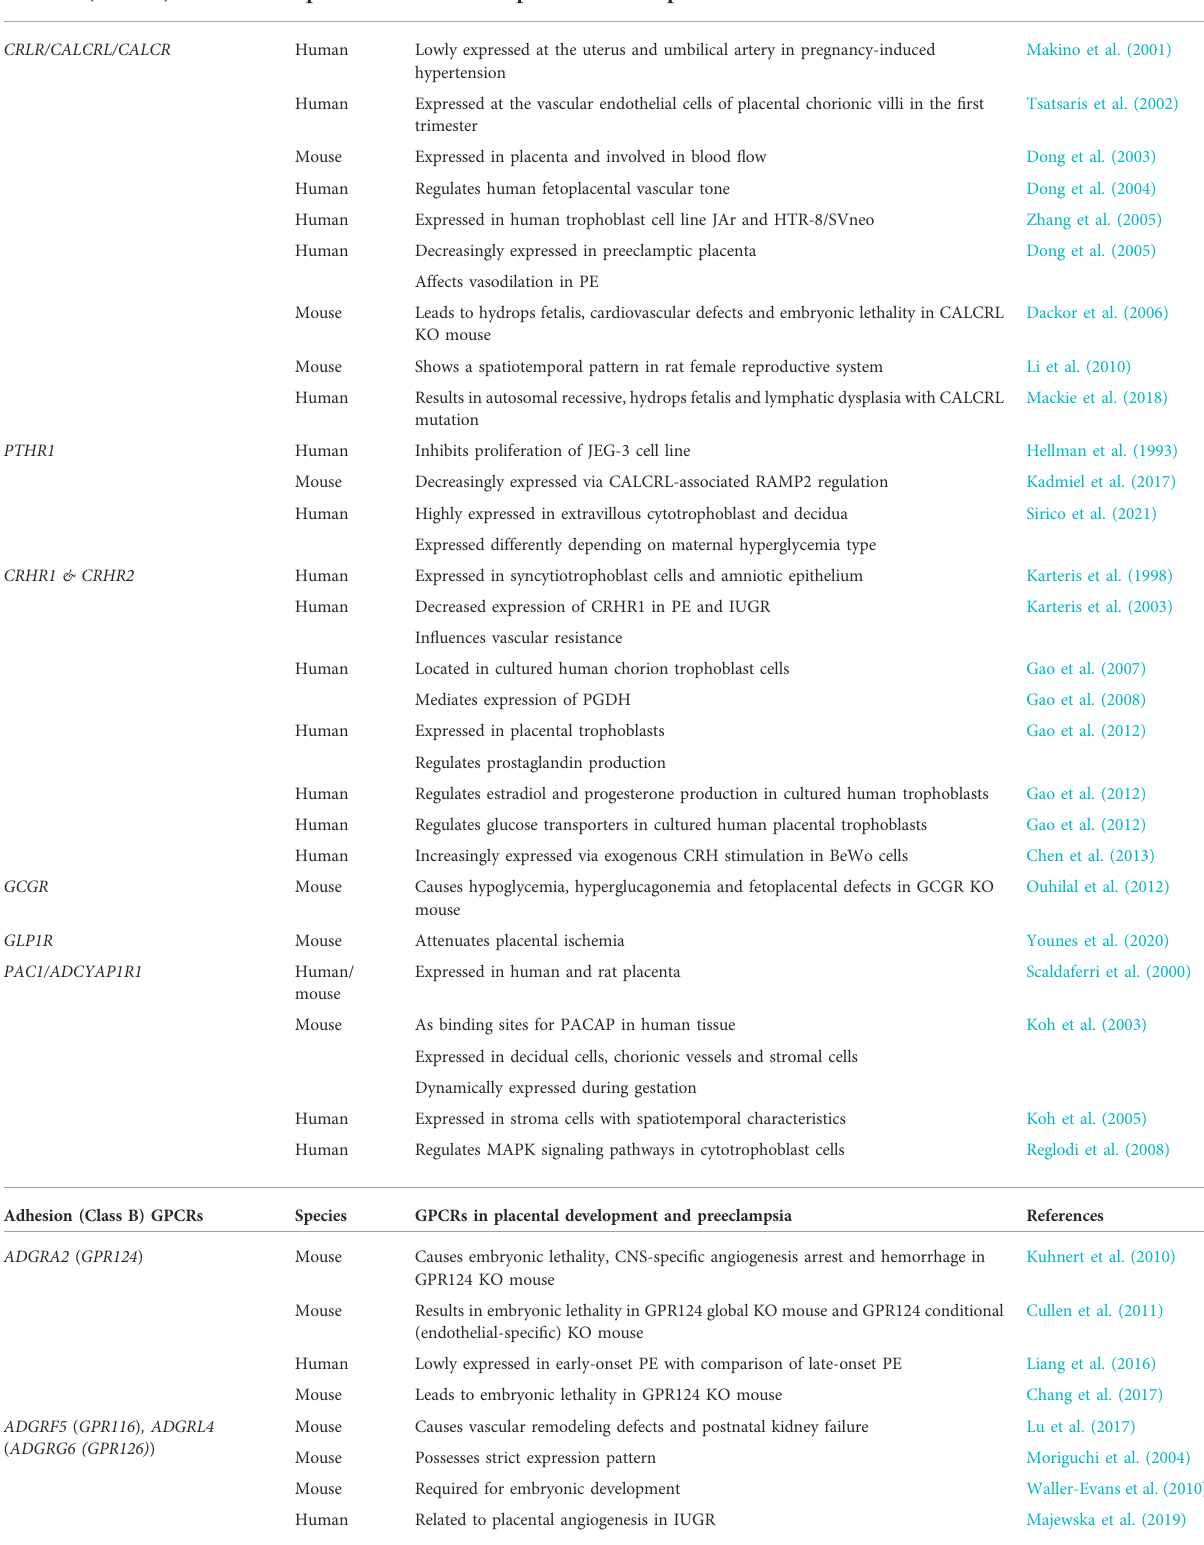
TABLE 1 The secretin/adhesion (class B) GPCRs in placental development and